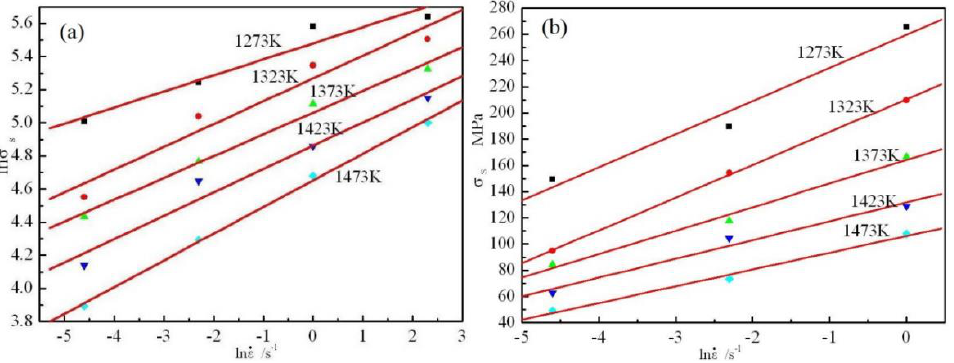
. ε and ( b ) σ s vs. ln s vs. ln